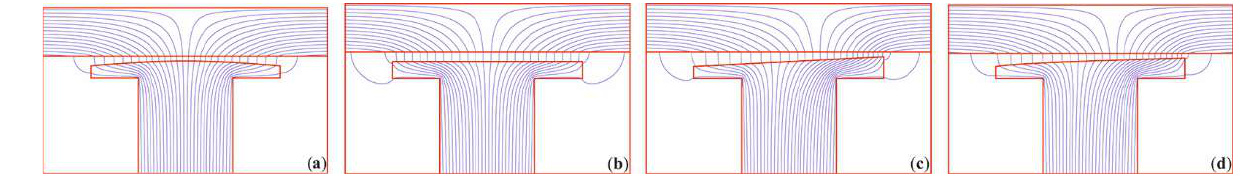
Figure 11. Shape evolution of the magnetic pole of electrically excited SM: sinusoidal air gap ( a ); constant air gap ( b ); linear air gap ( c ); optimized air gap ( d ).